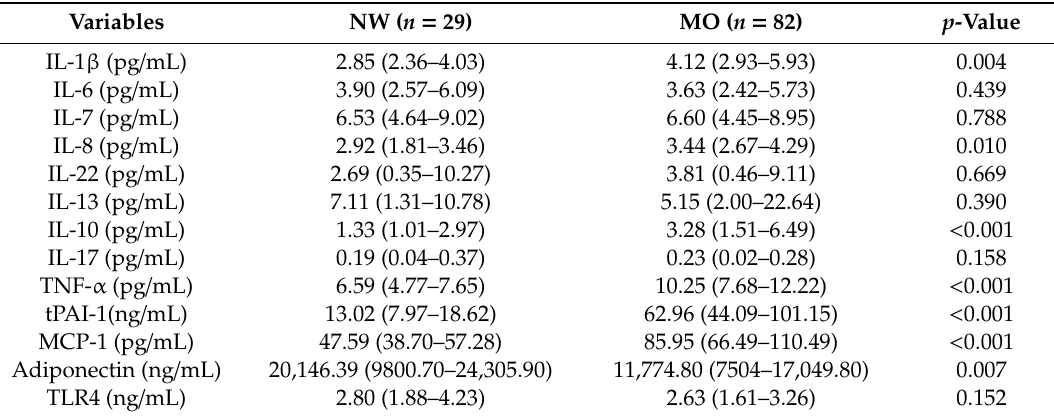
Table 2. Circulating levels of cytokines and TLR4 in women with morbid obesity and normal-weight